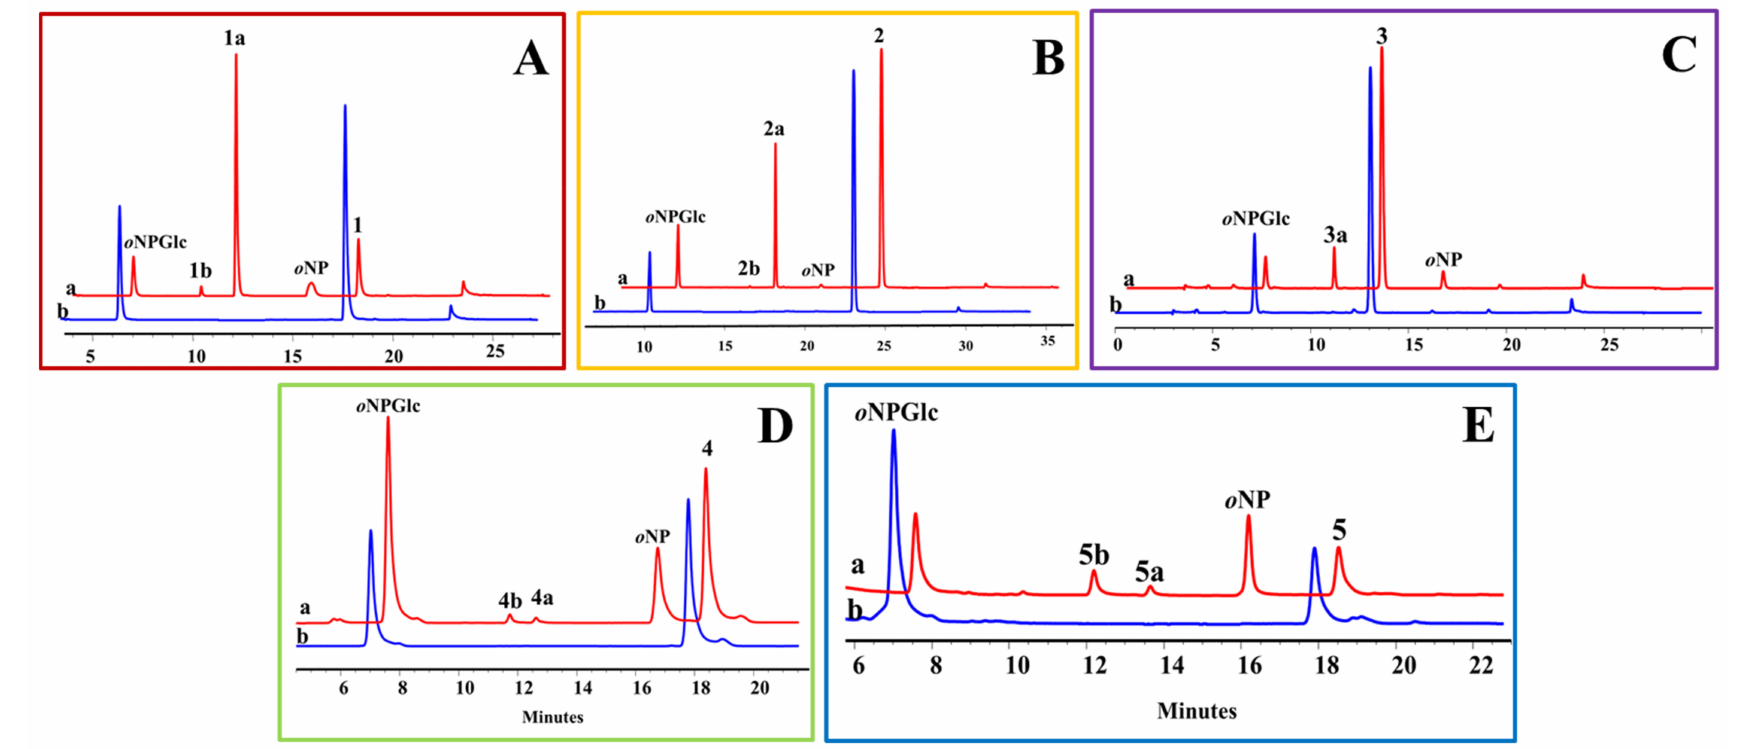
Figure 7. HPLC profiles of OcUGT1-assisted transglucosylation between o NPGlc and testosterone ( A ), deoxycorticosterone ( B ), hydrocortisone ( C ), estradiol ( D ) or 4-androstenediol ( E ). ( a ) Transglucosylation reaction with purified OcUGT1; ( b ) transglucosylation reaction without purified